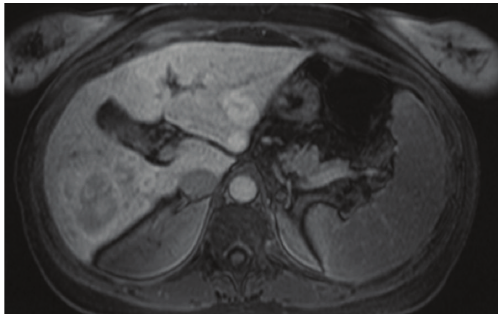
Figure 2: MRI abdomen with and without IV contrast. Multiple masses were scattered throughout the liver. The largest mass in right hepatic lobe measured 4.5